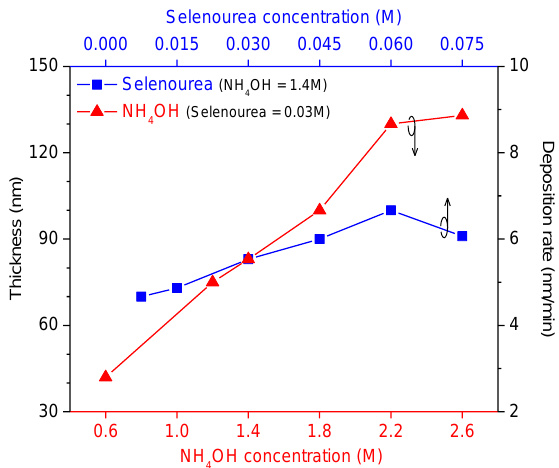
Figure 4. FESEM images of cross-sectional views for Zn(Se,OH) films deposited with a constant ammonia concentration of 1.4 M, and the selenourea concentrations of ( a ) 0.0075 M; ( b ) 0.015 M; ( c ) 0.03 M; ( d ) 0.045 M; ( e ) 0.06 M and ( f ) 0.075 M.